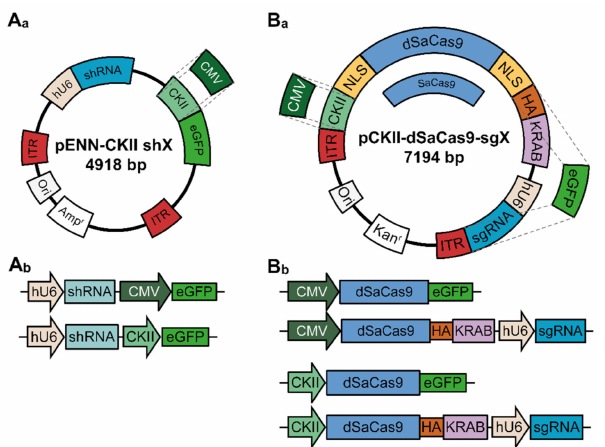
Figure 1. Construction of shRNA-encoding and all-in-one dSaCas9-encoding vectors for Adeno- associated viruses (AAV)-mediated RNA interference (RNAi) and CRISPRi. ( A a ) Schematic repre- sentation of the shRNA expression plasmid. ( A b ) Schematic representation of shRNA-encoding constructs used in this study. Expression of the eGFP reporter could be driven by the CMV- or CKII promoter. ( B a ) Schematic representation of the dSaCas9 and sgRNA expression plasmid. ( B b ) Schematic representation of sgRNA and dSaCas9-encoding constructs used in this study.